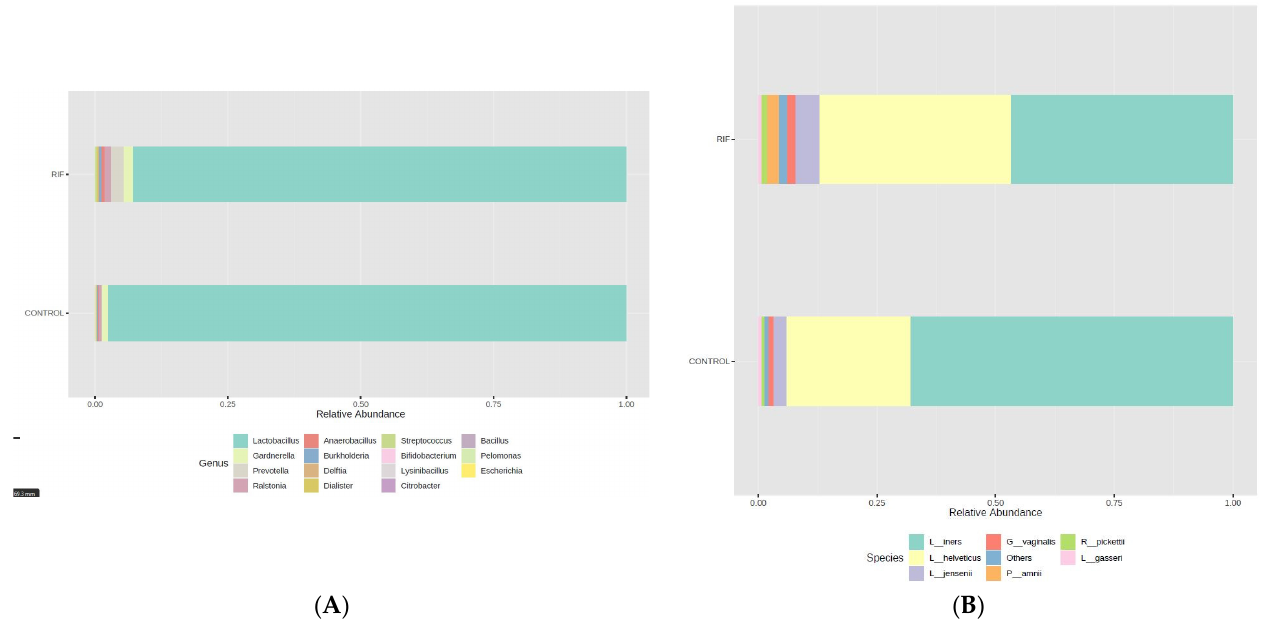
Figure 3. Composition of the bacterial community. Bar chart of the relative frequency of the most abundant genera ( A ) and species ( B ), grouped by RIF and control group. MicrobiomeAnalyst MDP.